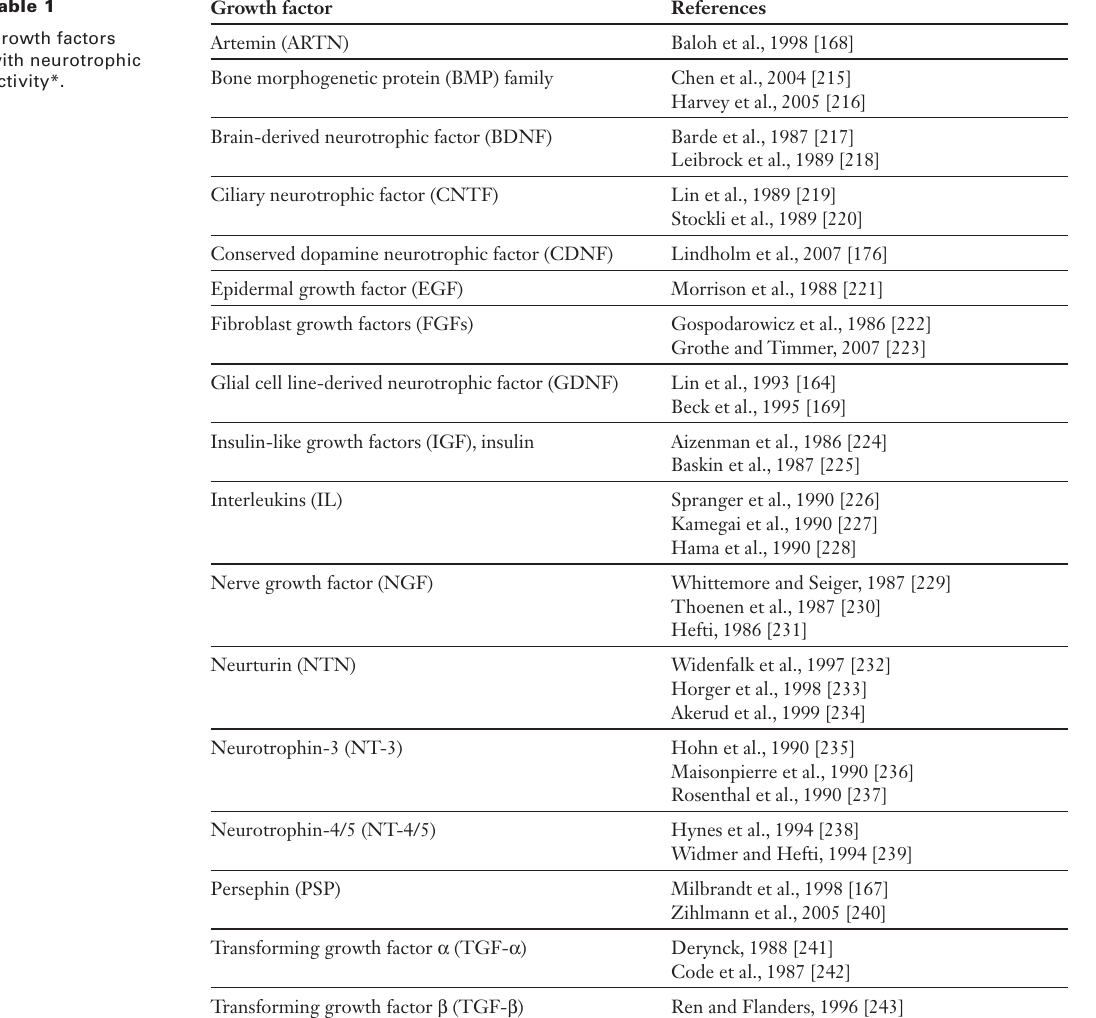
Growth factors with neurotrophic activity*.